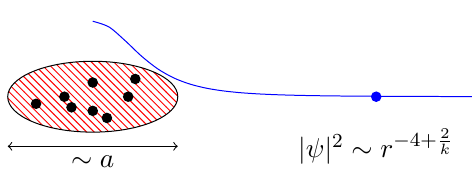
Figure 4 . Adding one particle to a (2 k from the centre of mass, it should be a good approximation to treat this as a charge 2 k interacting with a charge 1